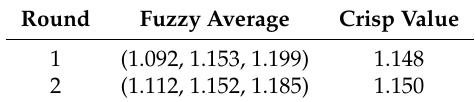
Table 2. Fuzzy mean and defuzzified value for rounds 1 and